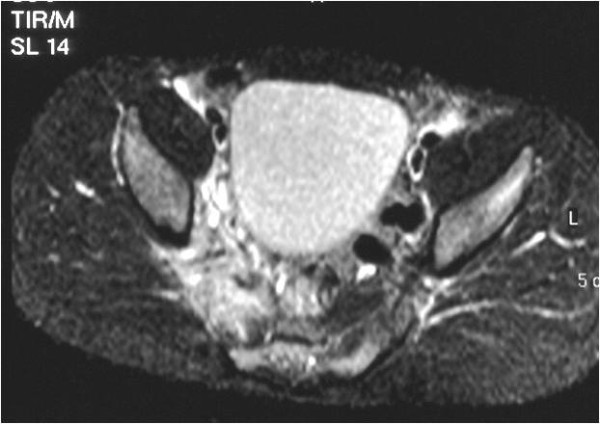
Axial short tau inversion recovery (STIR) image; MRI scan taken at the time of antibiotic treatment initiation. The right piriformis muscle is enlarged, bulging anteriorly, with high signal intensity within and loss of definition of its muscle striations, consistent with edema. Compare to the normal piriformis muscle on the left.